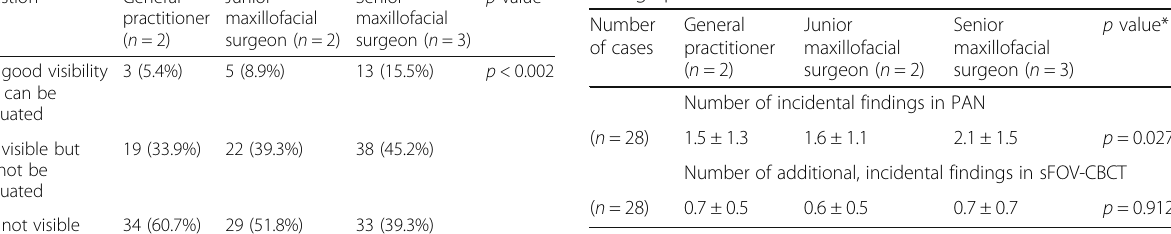
Table 1 Results of the question “ Based on PAN, the clinical area of interest, is …”